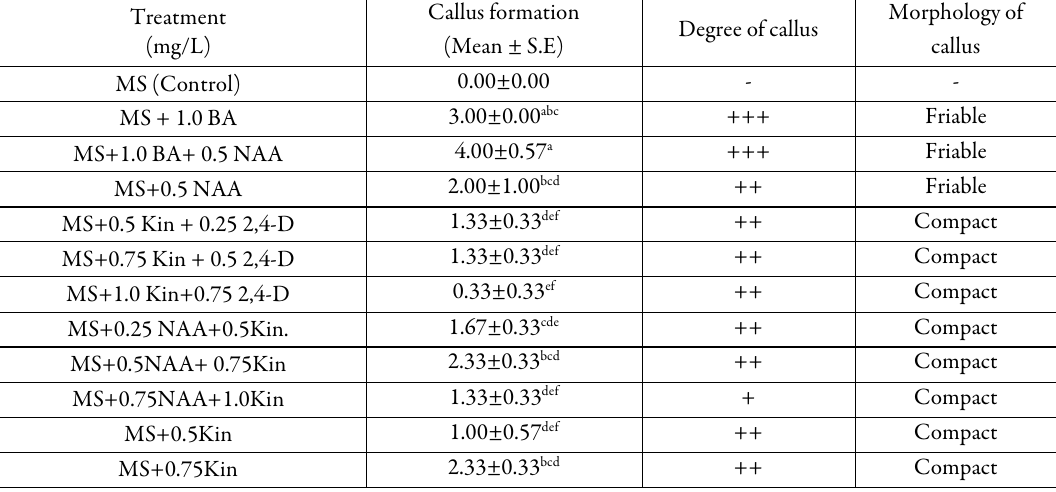
Table 4. Effect of different concentrations of auxins (NAA and 2, 4-D) and cytokinins (BA and kinetins) on callus formation from tuber explants of P .